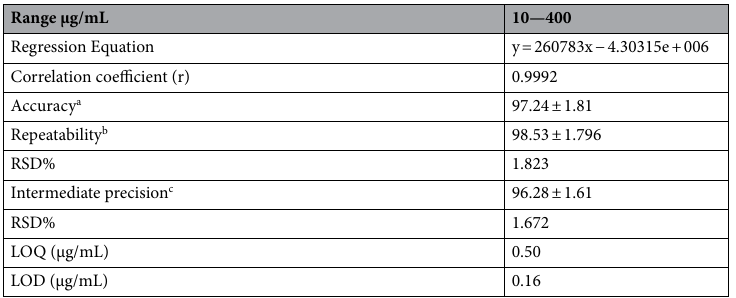
Table 3. Calibration curve equation and linearity (n = 6), intra-day and inter-day precision, accuracy, and LOQ and LOD. a: Six concentrations covering the range (10–400 µg/mL ). b: Intra-day (n = 3), an average of three concentrations of the analyte ( 15, 40, and 200 µg/mL ) repeated 3 times within the same day. c: Inter-day (n = 3), an average of three concentrations of the analyte ( 15, 40, and 200 µg/mL ) repeated 3 times in three consecutive days.